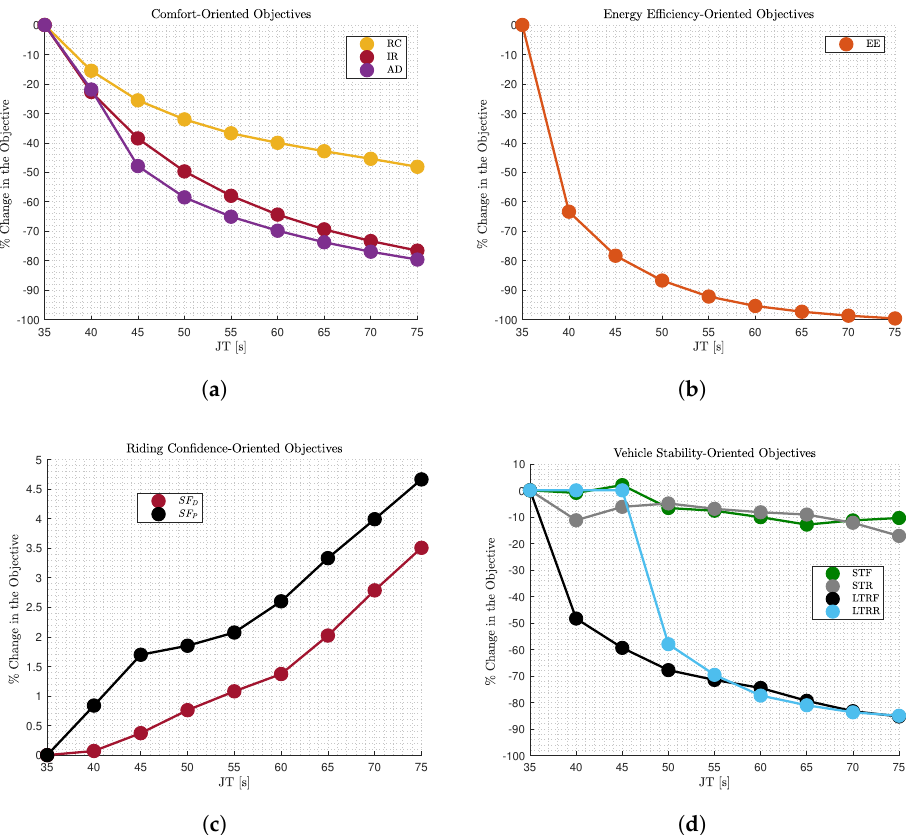
Figure 6. Additional ( a ) comfort-oriented, ( b ) energy efficiency-oriented, ( c ) riding confidence, ( d ) vehicle stability-oriented performance metrics evaluated by the outputs of an IGP/CarMaker 8.0 vehicle model following the predefined path with the assigned velocity obtained by the OCP (Figure 5b) for different fixed time